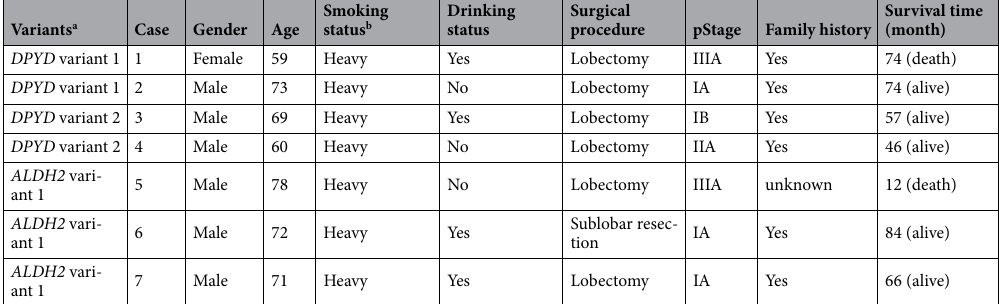
Table 4. Characteristics of all patients (n = 7) of lung squamouse cell carcinoma with DPYD and ALDH2 variants. a Variants; DPYD variant 1, variant2, and ALDH2 variant1 indicate rs190771411 (A > G), rs200562975 (T > C), and rs568781254 (A > C), respectively. b Smoking status; Light smokers (0 < to < 20), Heavy smokers (> 20), as shown in Table 2.